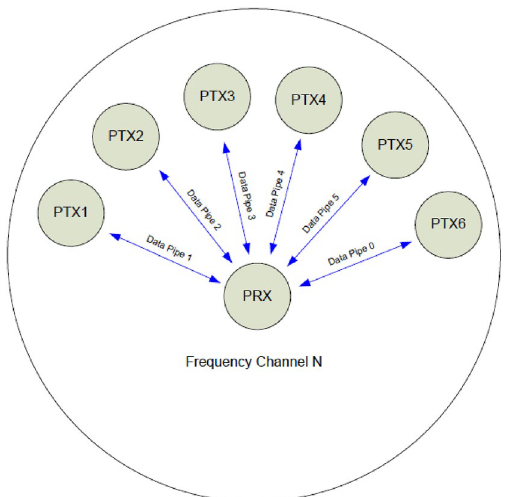
Fig. 3 MultiCeiver ™ Feature [24]